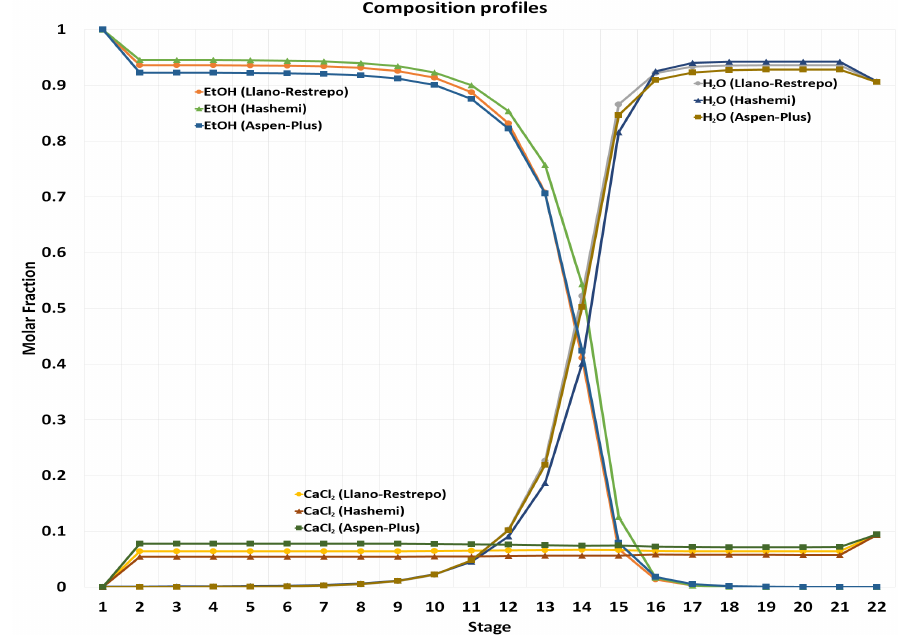
Figure 1. Composition profiles of the salt extractive distillation column. Comparison between Llano-Restrepo et al. [26] and Hashemi et al.